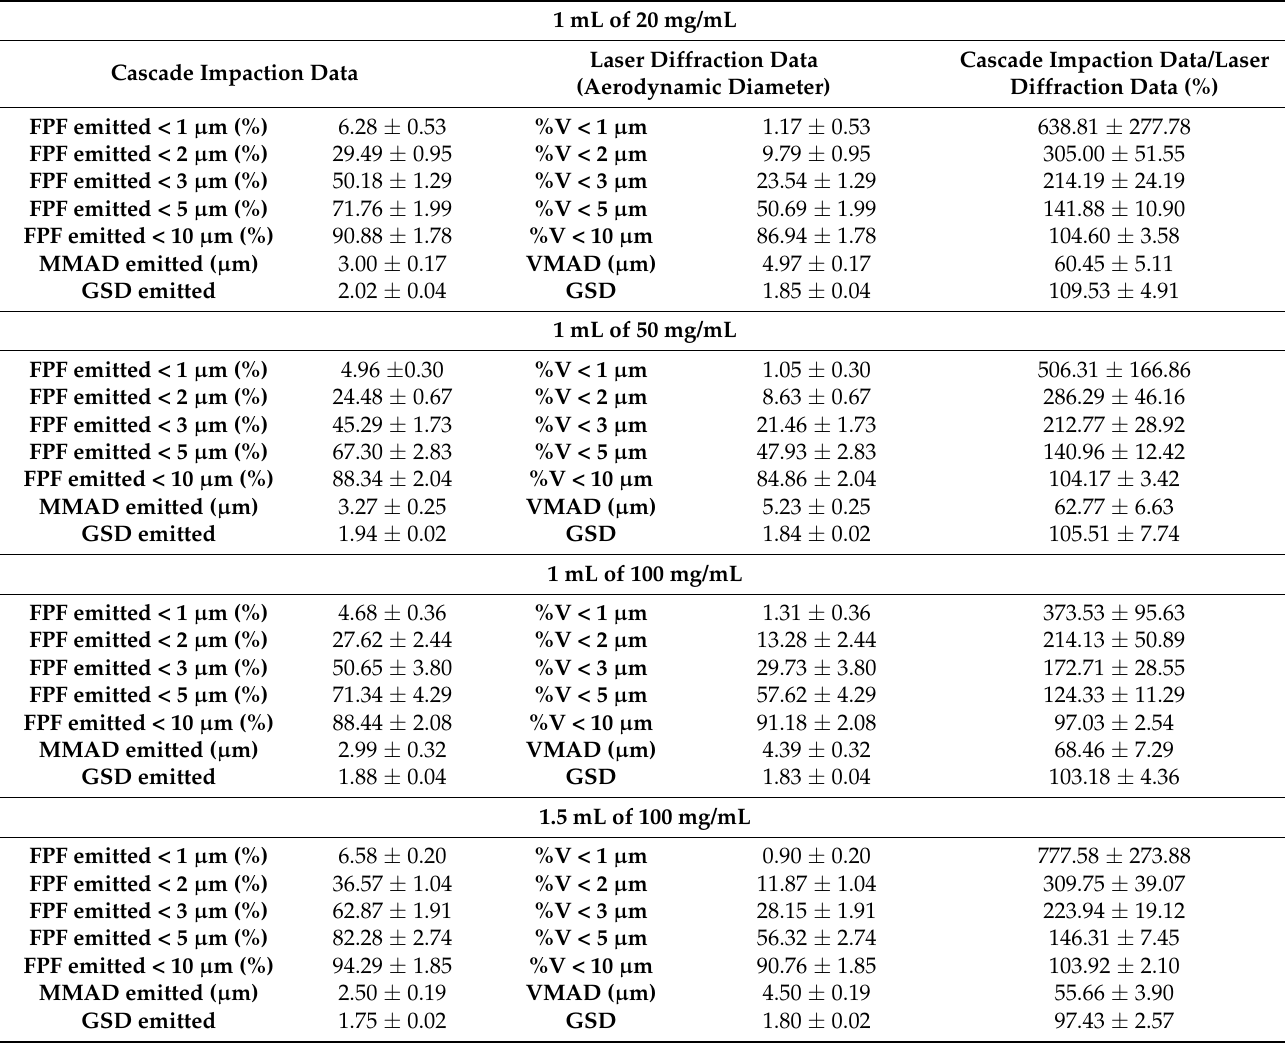
Table 8. Comparison of cascade impaction and laser diffraction